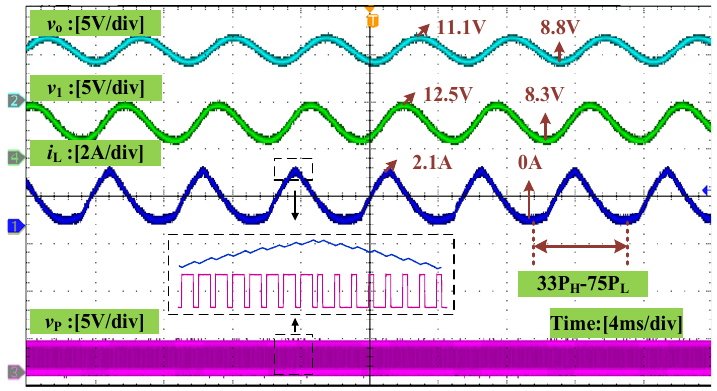
Figure 12. Experimental waveform under the traditional PT control.